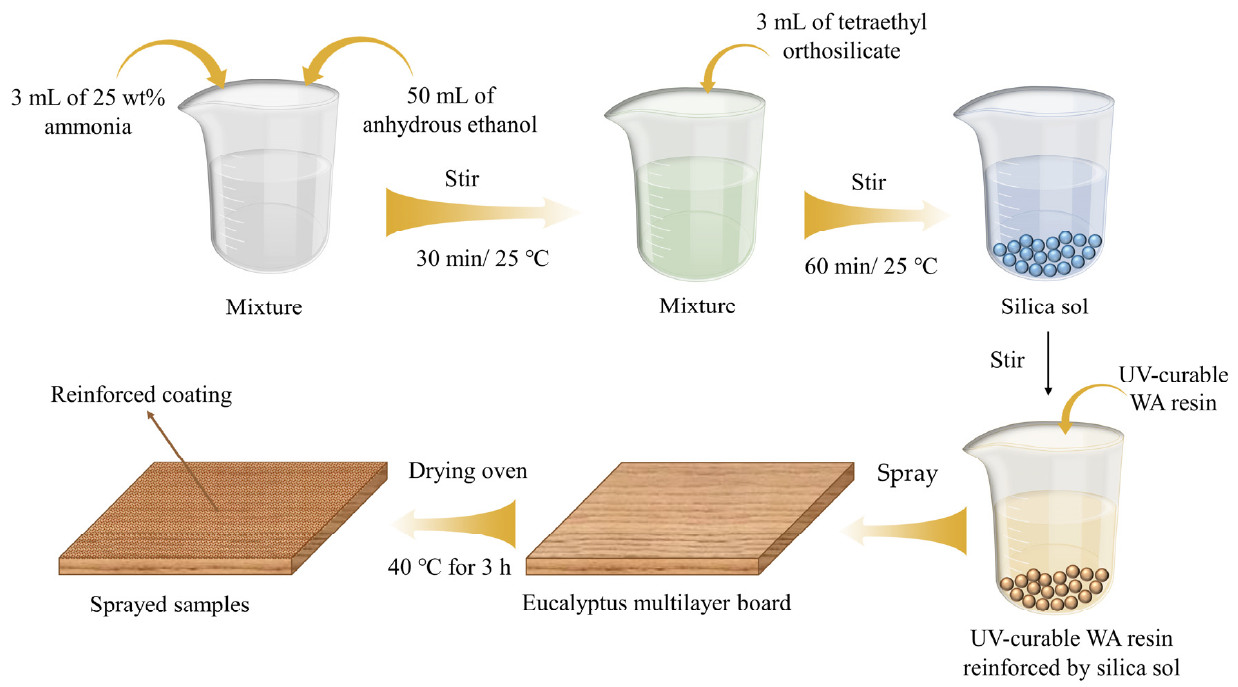
Figure 1. Schematic diagram of the preparation process for the reinforced coating.